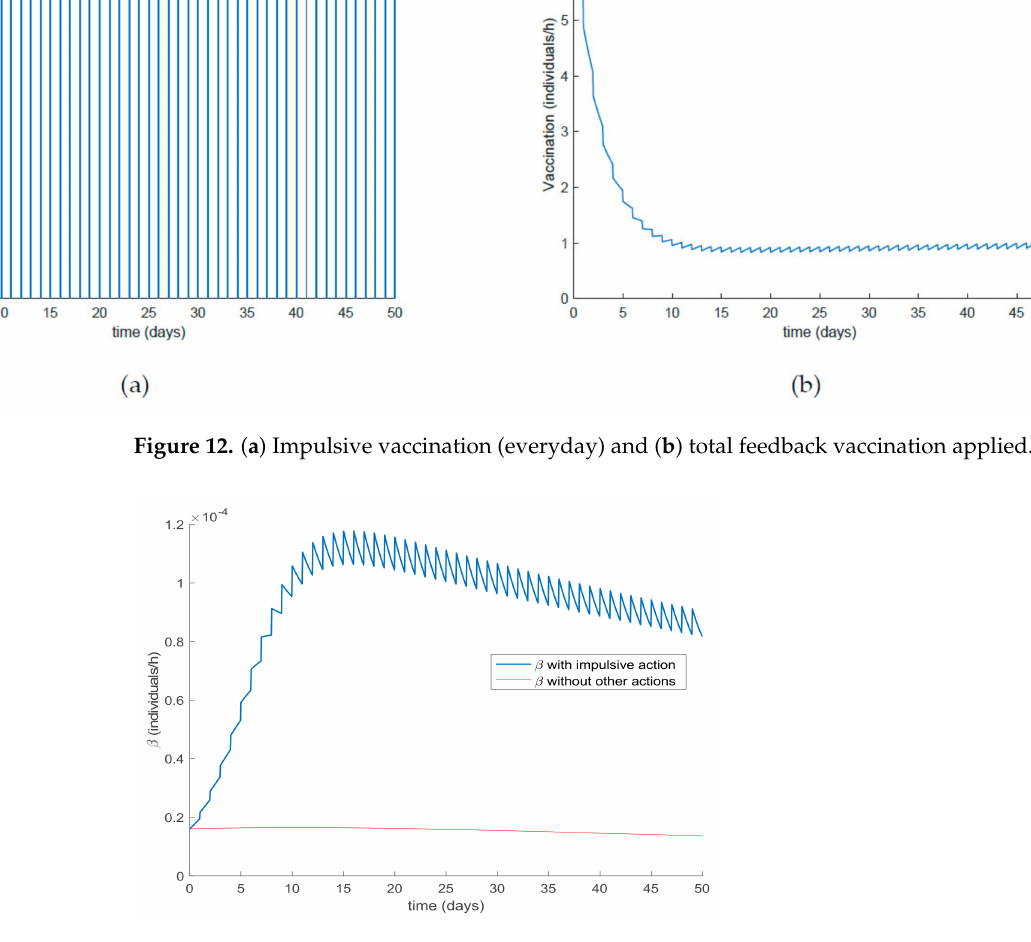
Figure 13. Value of β obtained through (30) when only the contagion rate is applied and when all control actions are